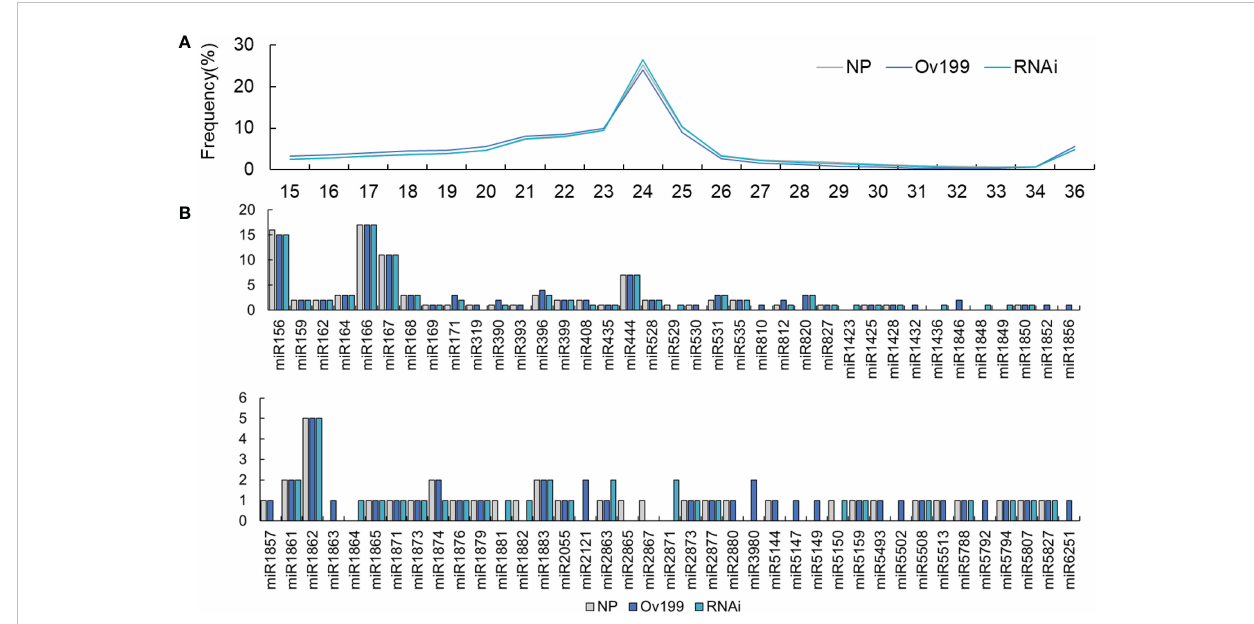
FIGURE 2 Number of identi fi ed members of each conserved miRNA families in NP, Ov199 and RNAi. (A) Size distribution of the small RNA in NP, Ov199 and RNAi lines. (B) Number of identi fi ed members of each conserved miRNA families in NP, Ov199 and